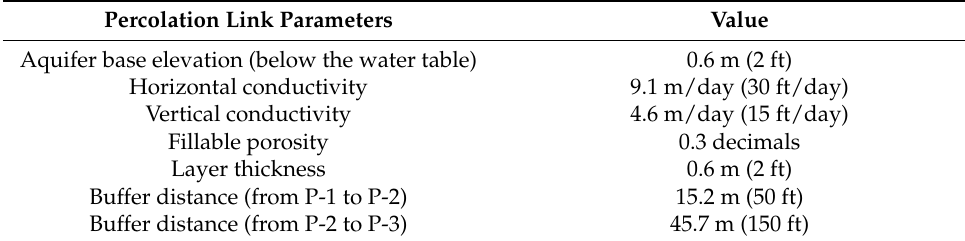
Figure 9. Post-development percolation link delineation. Table 4. Percolation link